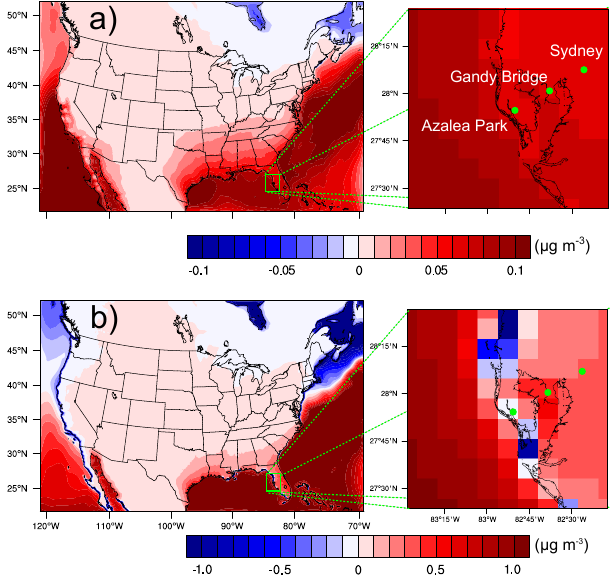
Figure 1. Change in the (a) fine mode and (b) total surface sodium concentration between the revised and baseline simulations for May 2002 over the continental US and BRACE domains with sites from left to right: Azalea Park, Gandy Bridge, and Sydney as green